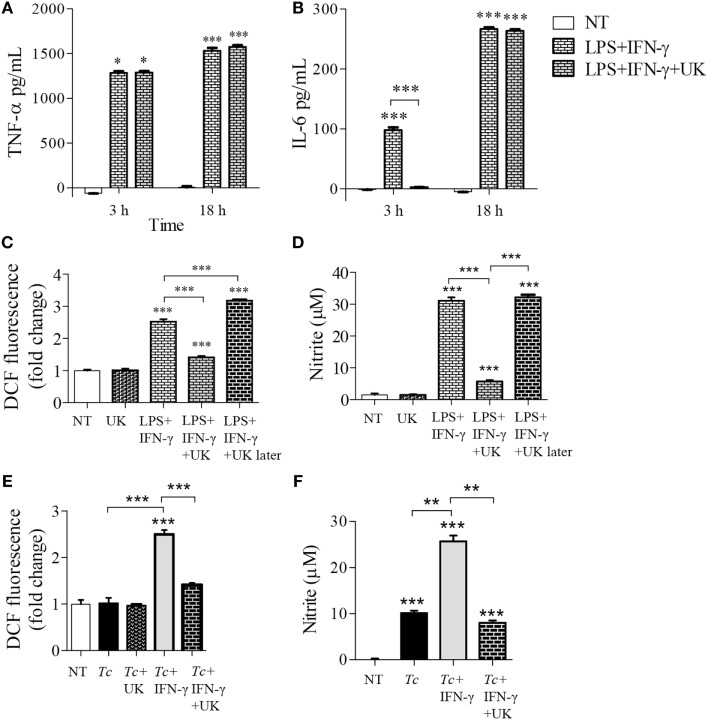
Role of mitochondrial pyruvate in the pro-inflammatory activation of macrophages. (A–D) RAW 264.7 macrophages were incubated with lipopolysaccharide (LPS) + IFN-γ for 3 or 18 h in the presence or absence of pyruvate transport inhibitor UK5099 (UK). (C,D) RAW 264.7 macrophages were sequentially incubated, first with LPS + IFN-γ for 18 h, and then with UK5099 for 4 h. (E,F) RAW 264.7 macrophages were incubated with Trypanosoma cruzi (Tc) at the same time in presence or absence of IFN-γ and UK5099 for 18 h. An enzyme linked immunosorbant assay was used to quantify TNF-α (A) and interleukin (IL)-6 (B) release. Intracellular reactive oxygen species (C,E) and nitrite release (D,F) were determined by DCF fluorescence and Griess assay, respectively. All data are shown as the mean ± SEM of ≥3 biological replicates (triplicate observations per replicate). Significance is presented as ANOVATukey *p < 0.05, **p < 0.01, and ***p < 0.001 compared to no-treatment controls, and otherwise is marked by a line over comparing groups.